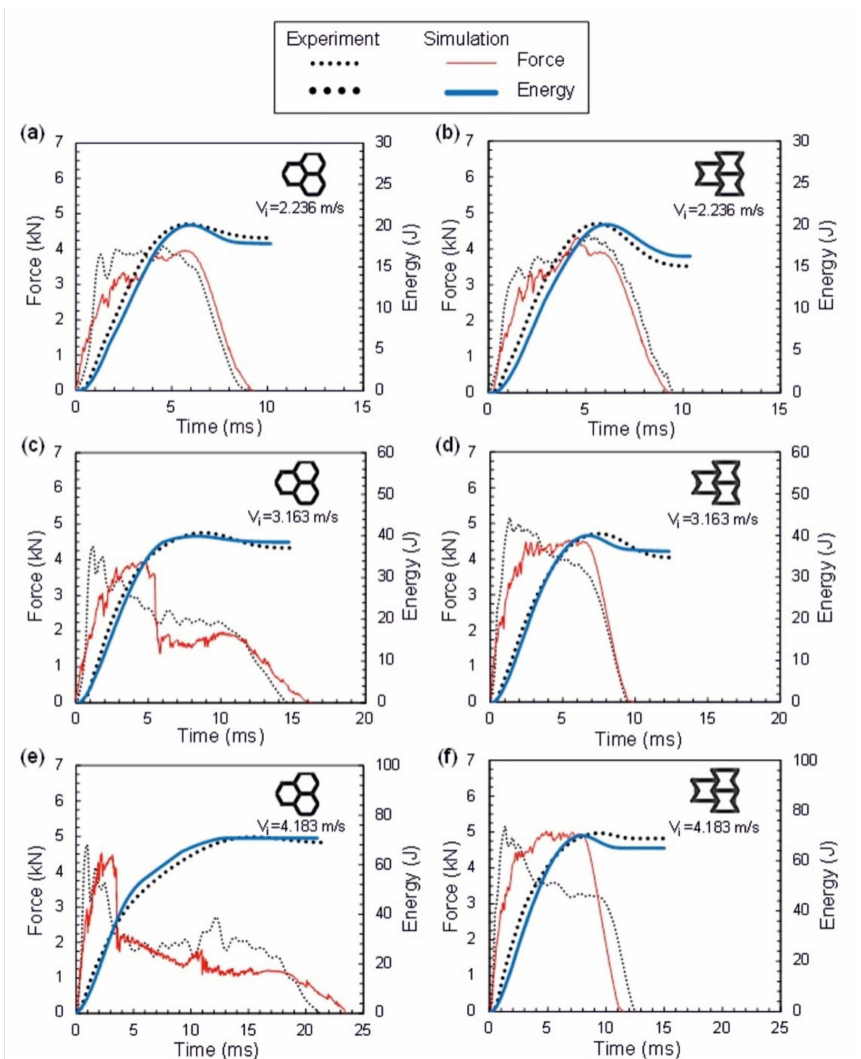
Figure 22. ( a – f ) Out-of-plane orientation experimental and FEM impact results of the honeycomb and re-entrant sandwich beam at velocities of 2.236, 3.163, and 4.183 m/s [180].